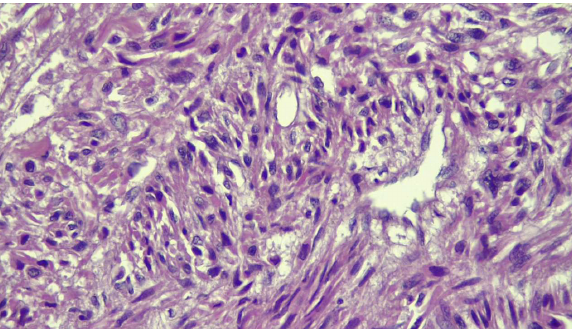
Figure 1: Abdominal CT scan showing a suspicious tissue mass in the left kidney.